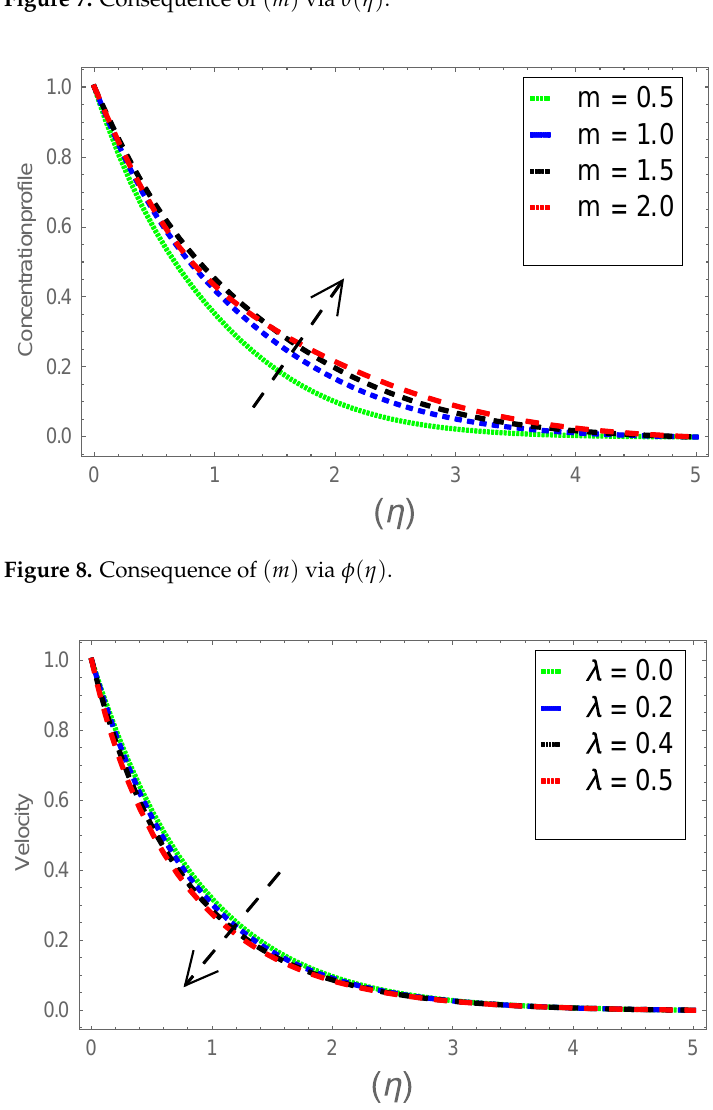
Figure 9. Consequence of ( λ ) via f (cid:48) ( η )